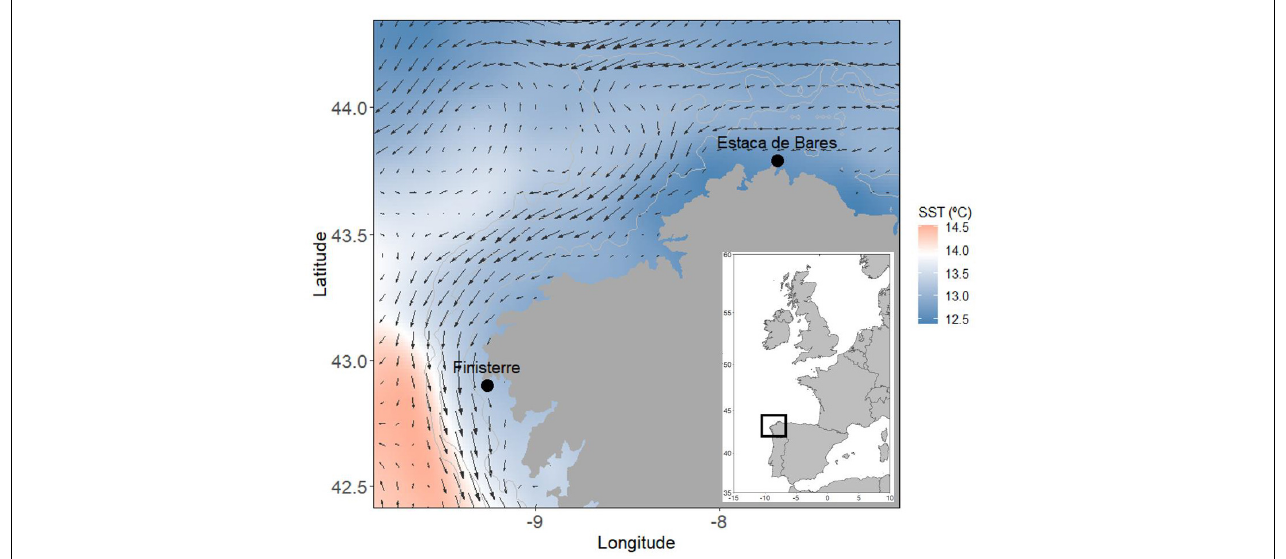
FIGURE 1 | Sampling area off the NW Iberian Peninsula (Galician shelf, the main spawning ground of the southern stock of Merluccius merluccius ) with the mean of sea surface temperature (SST) and currents for March of both the sampled years (2012 and 2017).